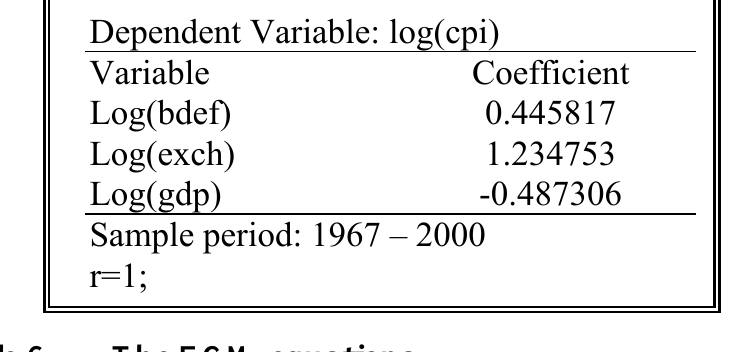
The ECM equations